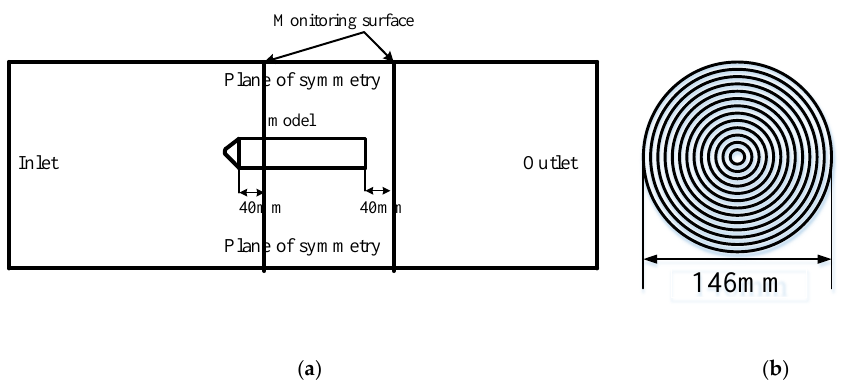
Figure 2. Experimental setup and computational geometric model.